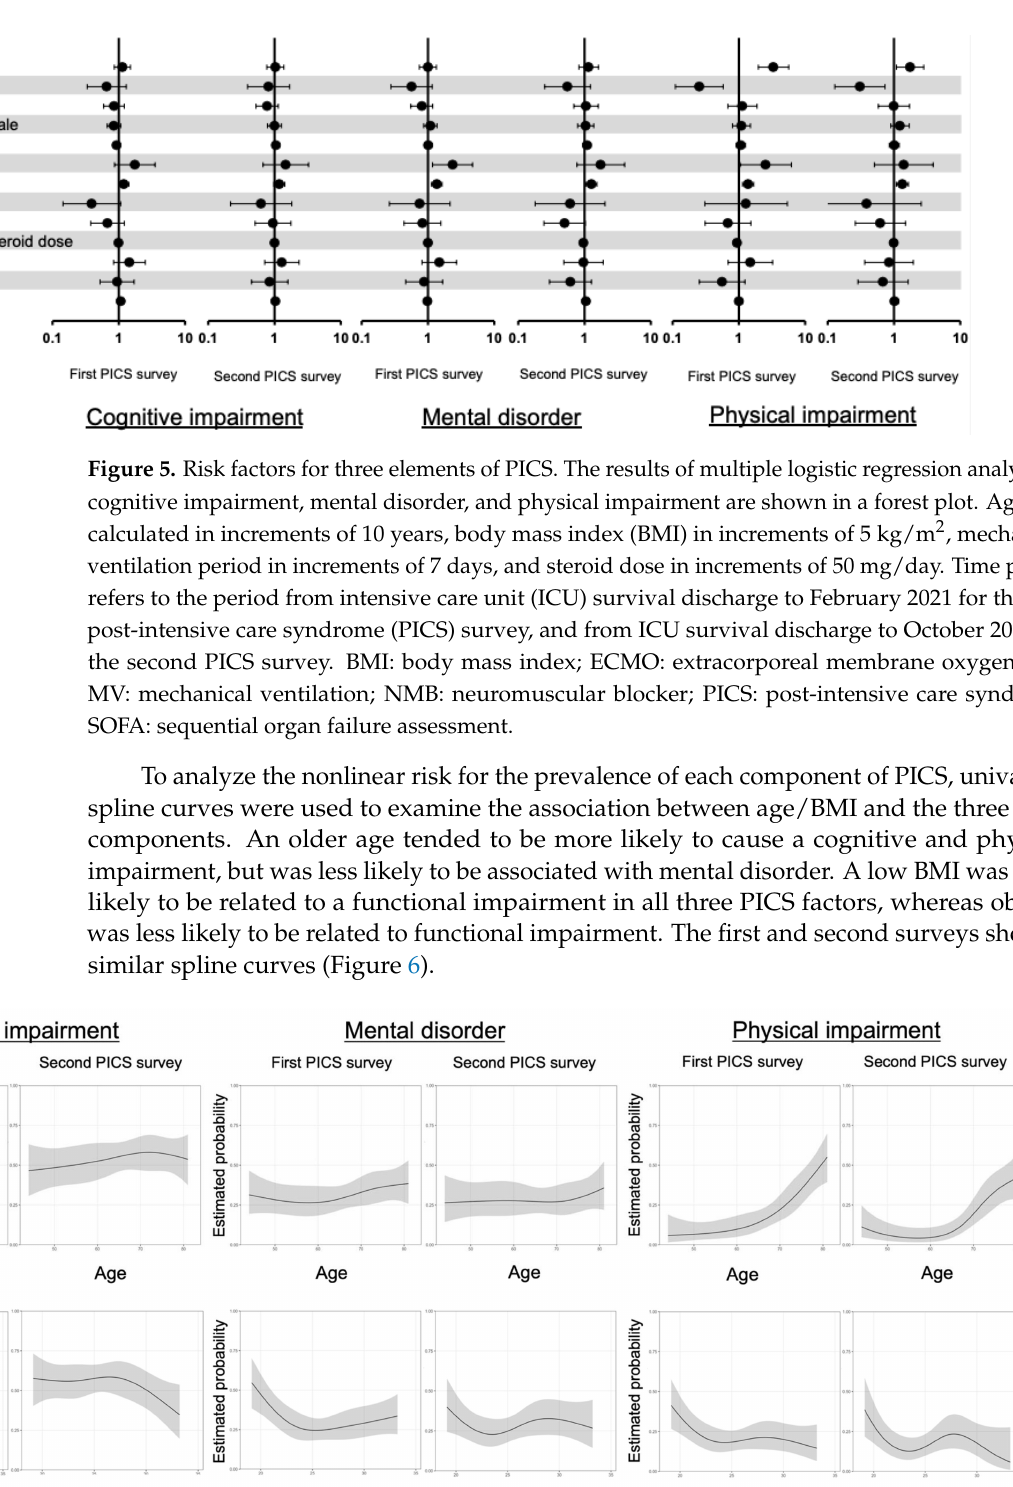
11 of 18 Figure 4. Risk factors for post-intensive care syndrome (PICS). Results of multiple logistic regression analysis of PICS are shown in a forest plot. Age was calculated in increments of 10 years, body mass